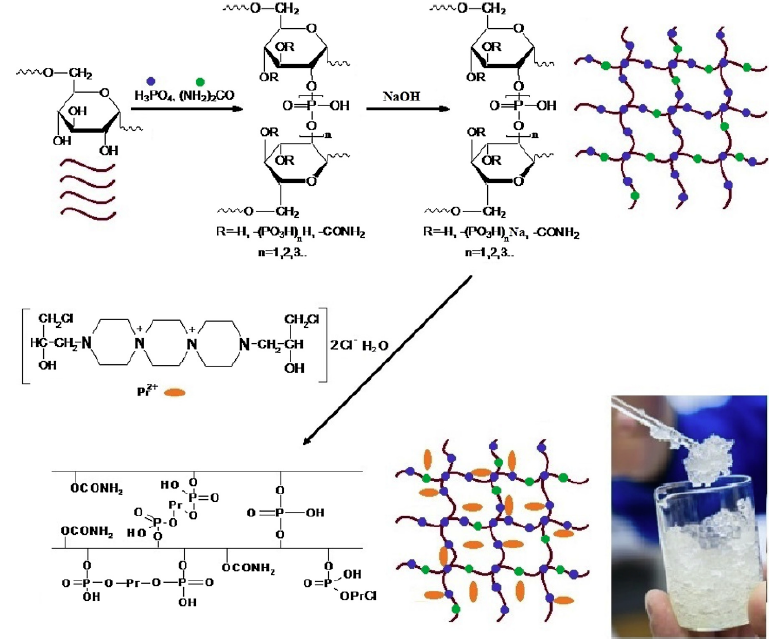
Figure 8. Schematic illustration of the synthesis of dextran phosphate (DP)–prospidine (Pr) hydrogels. Taken from [101].